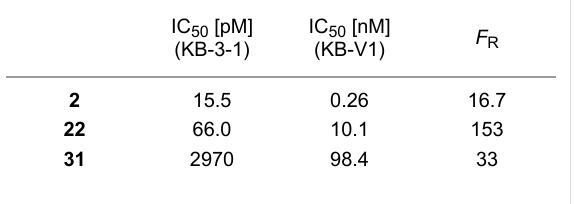
Table 1: Cytotoxicity of the fluorinated cryptophycins 22 and 31 in comparison to cryptophycin-52 ( 2